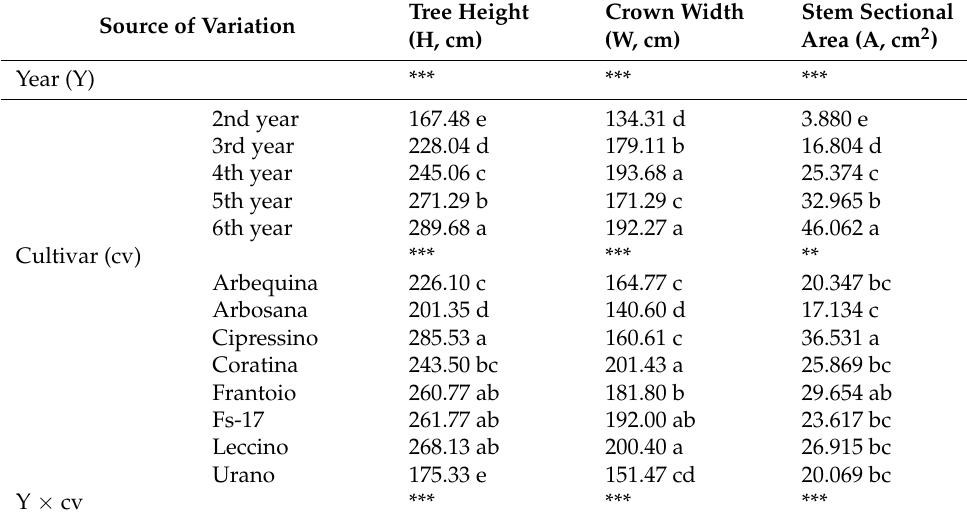
Table 1. Results of the repeated measures analysis carried out on canopy growth variables (Tree height, H; Crown width; Stem sectional area,